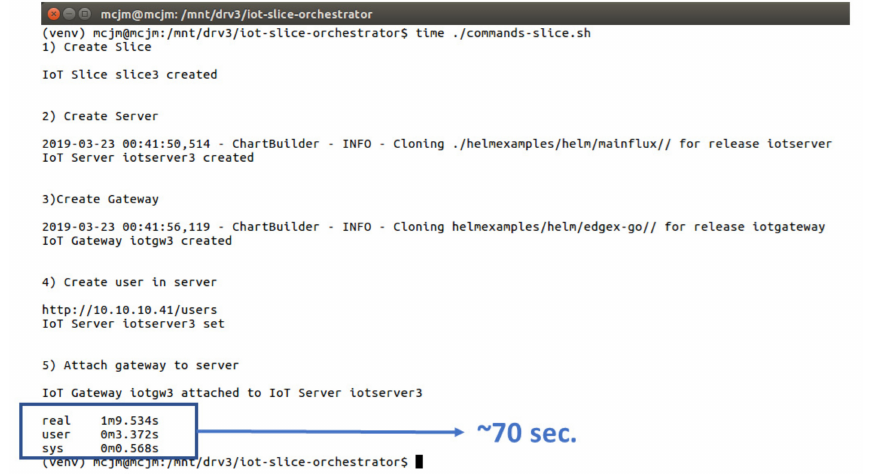
Figure A5. Time measured to deploy an IoT slice with its corresponding IoT gateway and IoT server in a custom Kubernetes